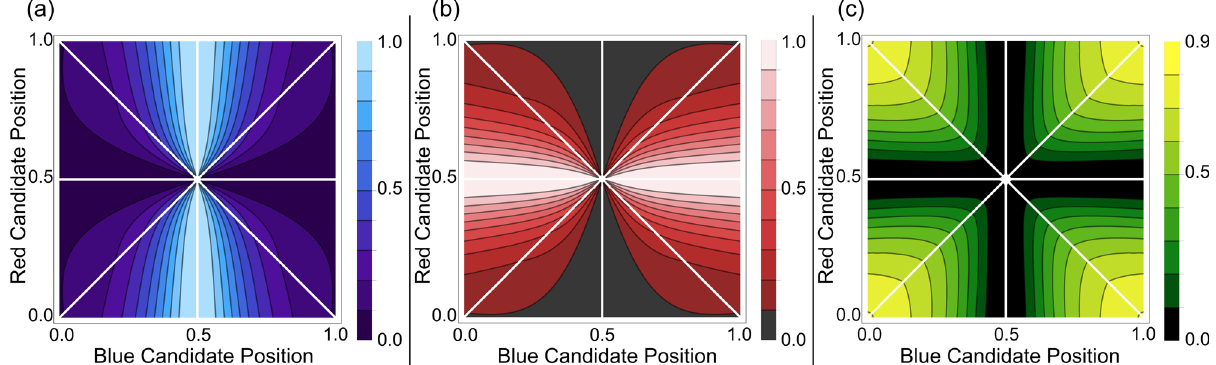
Fig. 3 Varying the candidates positions in fl uences a fi xed voter ’ s behavior. Each panel shows how the likelihood of a given voter behavior (voting “ blue ” in a , voting “ red ” in b , or voting for neither in c ) changes as a function of the two political candidates stated ideological position, [0, 1] 2 , assuming a voter ideology of 0.5, a speci fi c set of model parameters ( P = 2, Q = 30, R = 1). (The white lines crossing the space and point at the center re fl ect one- dimensional portions of the two-dimensional space where a candidate has the exact same preference as a voter ( r = 0.5 or b = 0.5), where the two candidates are identical ( r = b ), or where the voter is equidistant between the two candidates ( ∣ r − 0.5 ∣ = ∣ b − 0.5 ∣ ). In these subsets of the space, and their intersection at b = 0.5 = 0.5 the model loses practical interpretability for this single hypothetical